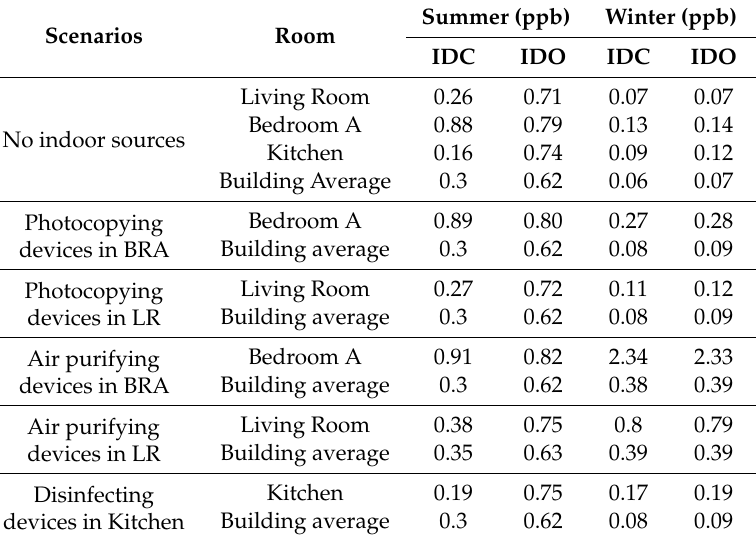
Table 6. Average indoor / outdoor (I / O) ratio of the main